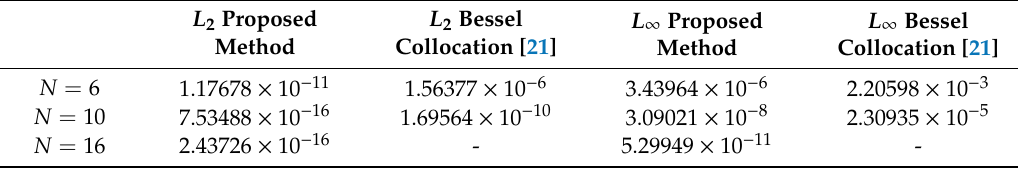
Table 6. Comparison of the L 2 , L ∞ errors norm. Table 6 . Comparison of the Table 6 . Comparison of the